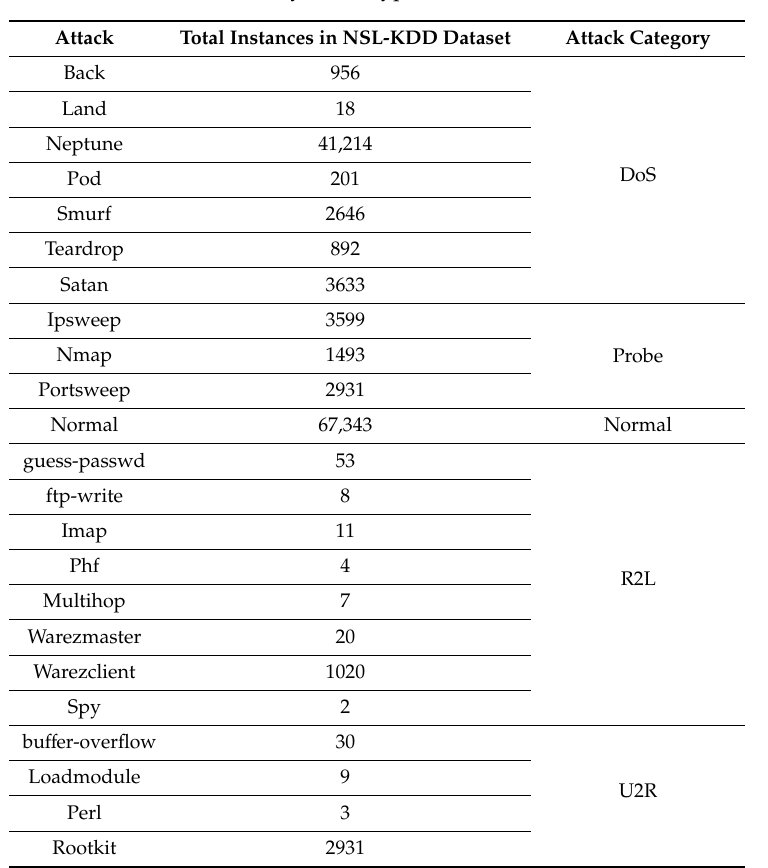
Table 2. Total instances by attack type in the NSL-KDD dataset